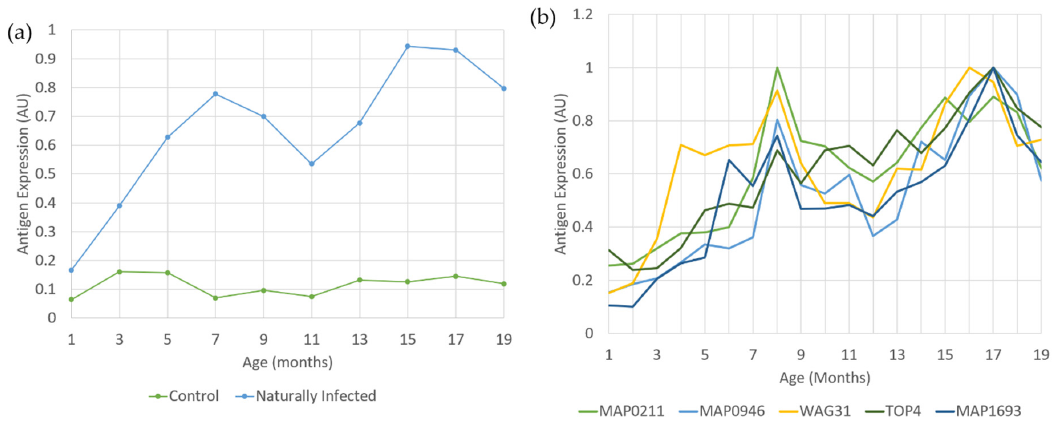
Figure 5. ( a ) Expression of WAG31 in naturally MAP-infected and control heifers between ~1 month and 19 months of age and ( b ) expression of MAP0211, MAP0946, WAG31, TOP4 and MAP1693 in naturally MAP-infected heifers between ~1 month and 19 months of age.